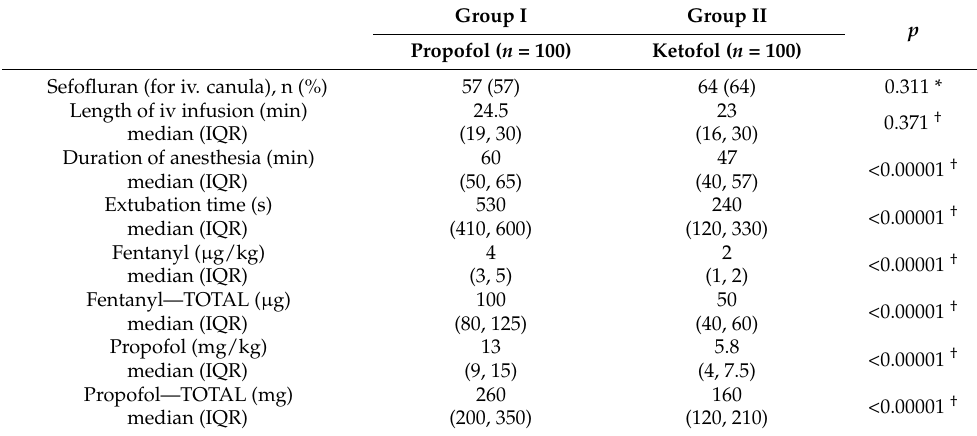
Table 2. Anesthesia data of patients.